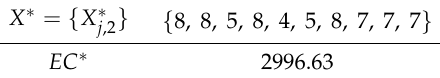
Table 7. Optimal release dates and cost in the case of assembly system (finished product is composed only of new complements).